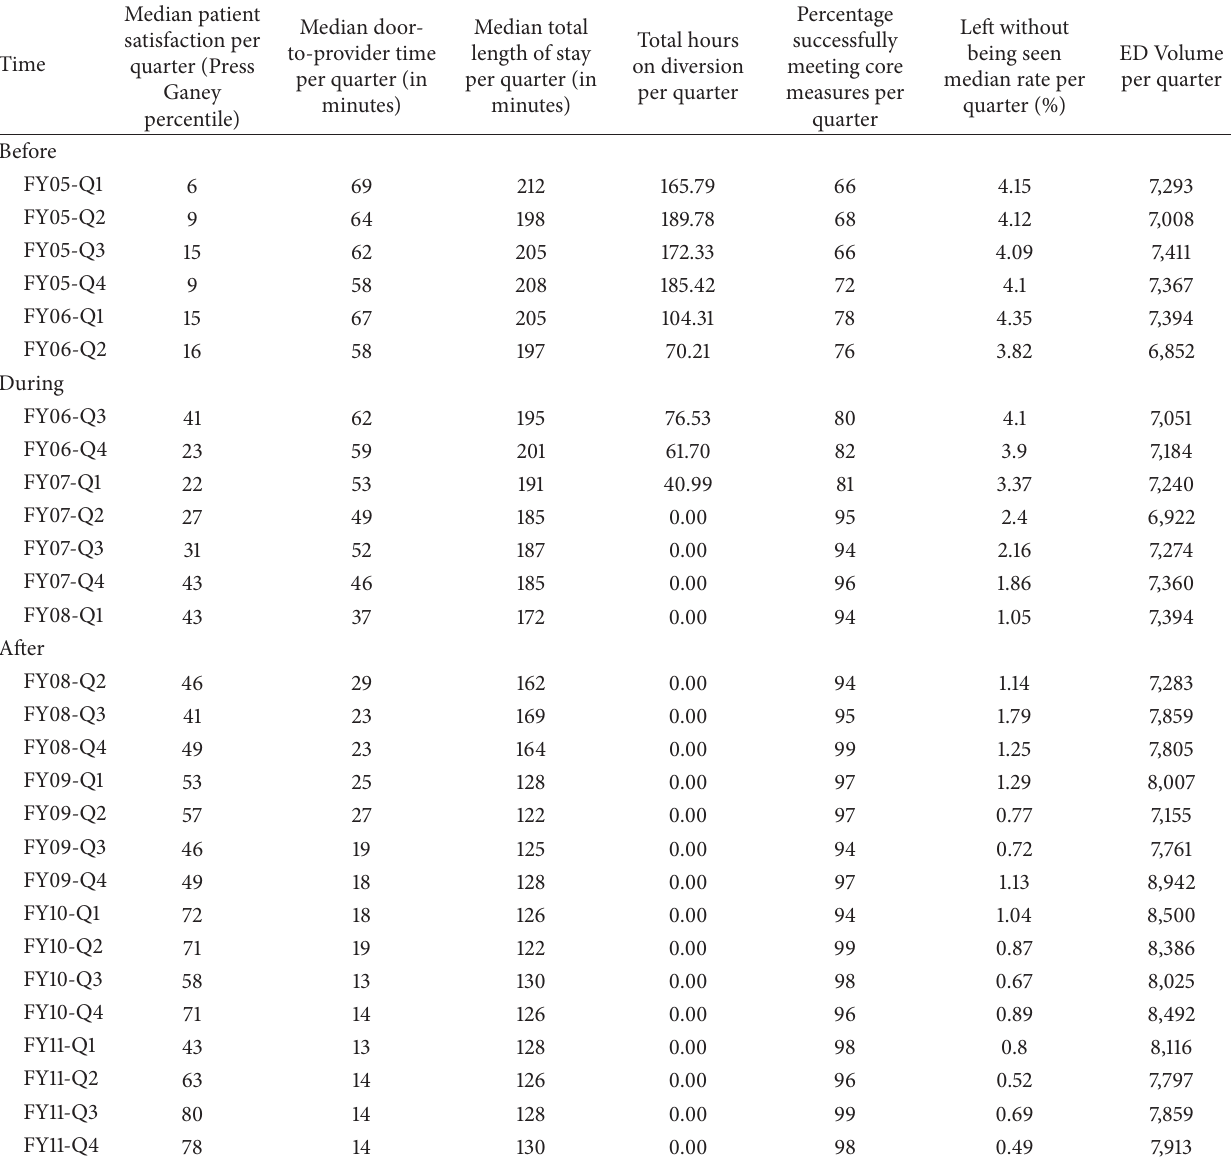
Table 1: Raw data used for statistical analysis, collected from January 2005 to December